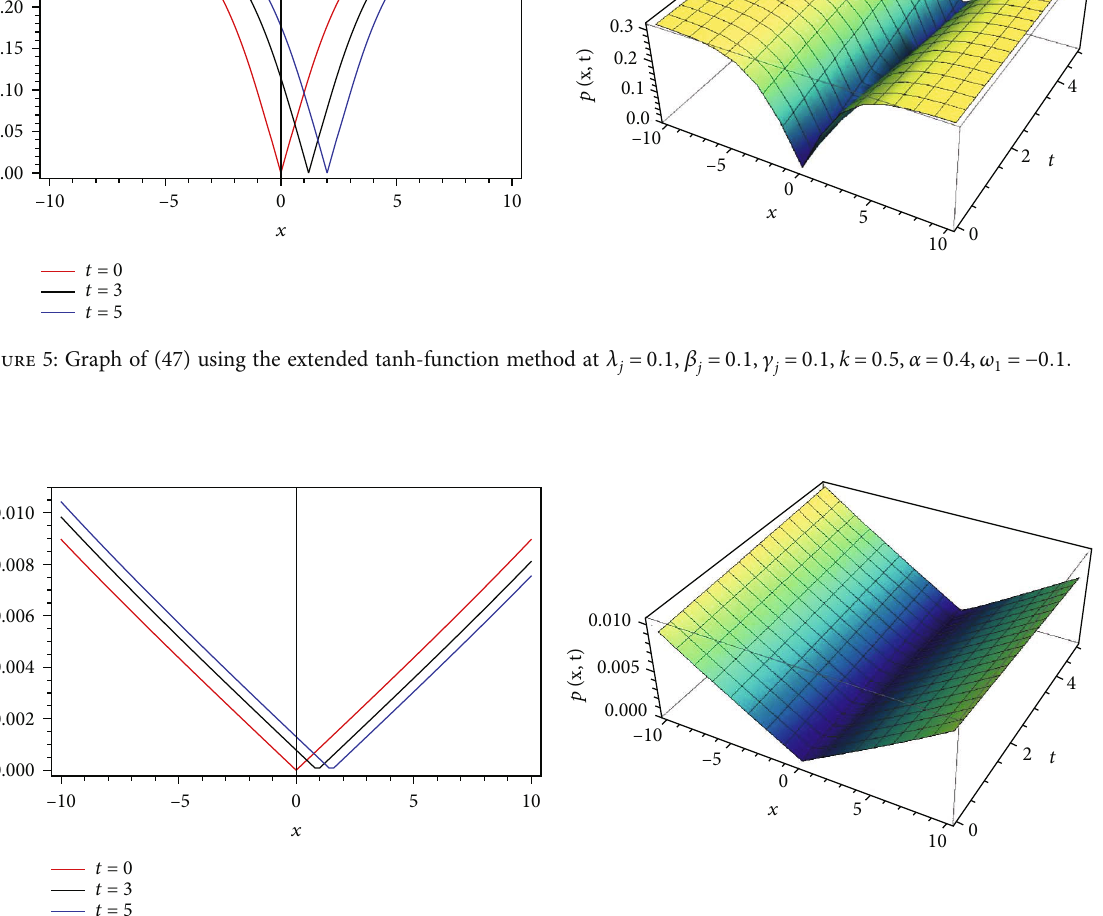
Figure 6: Graph of (50) using the extended tanh-function method at λ